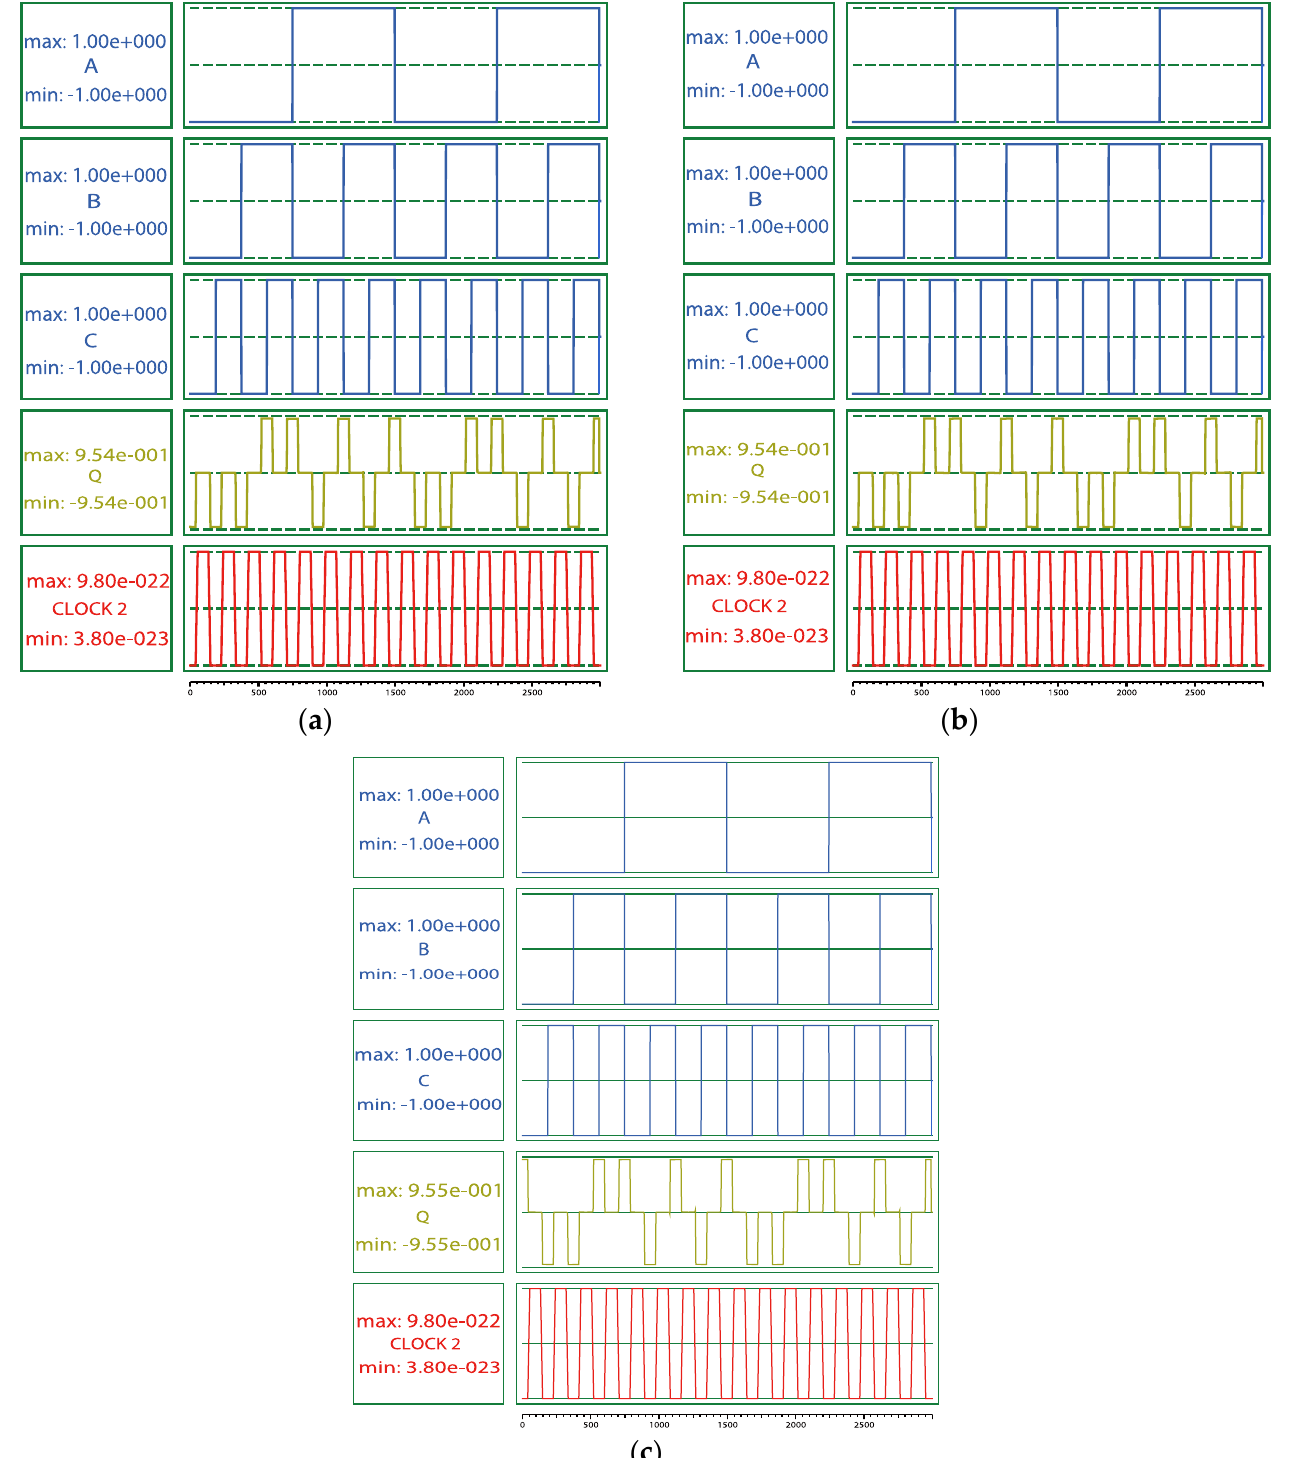
Figure 15. Simulation results of the proposed 2-to-1 multiplexers: ( a ) 2-to-1 MUX1, ( b ) 2-to-1 MUX2, and ( c ) 2-to-1 MUX3.